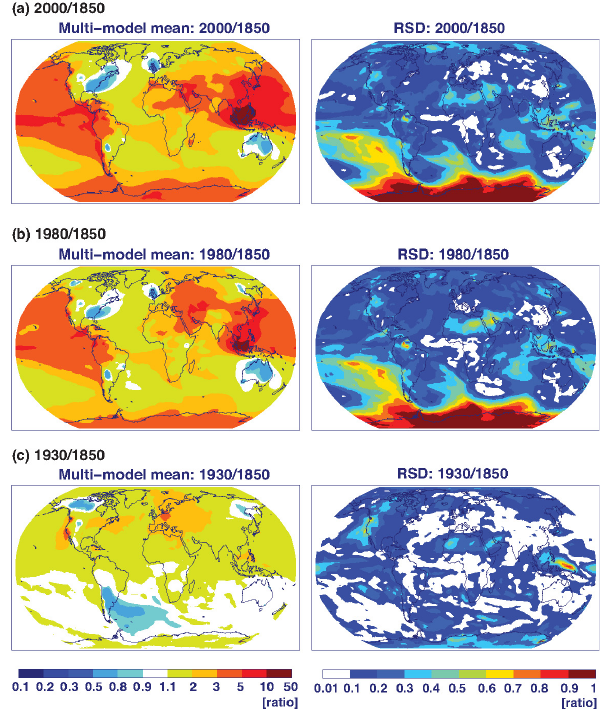
Fig. 5. Global distributions of the multi-model mean and RSD (rel- ative standard deviation) of ratios of total BC deposition fluxes in 2000, 1980, and 1930 to those in 1850. GFDL-AM3 and HadGEM2 did not run the 1930